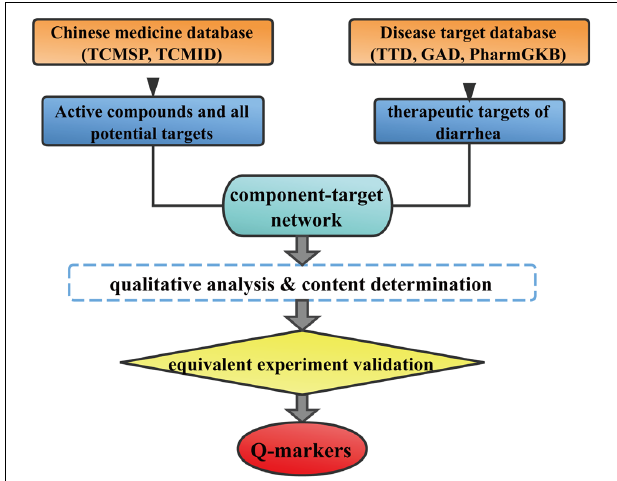
FIGURE 1 | Whole framework of Q-markers discovery of TCM based on systems pharmacology and a case of